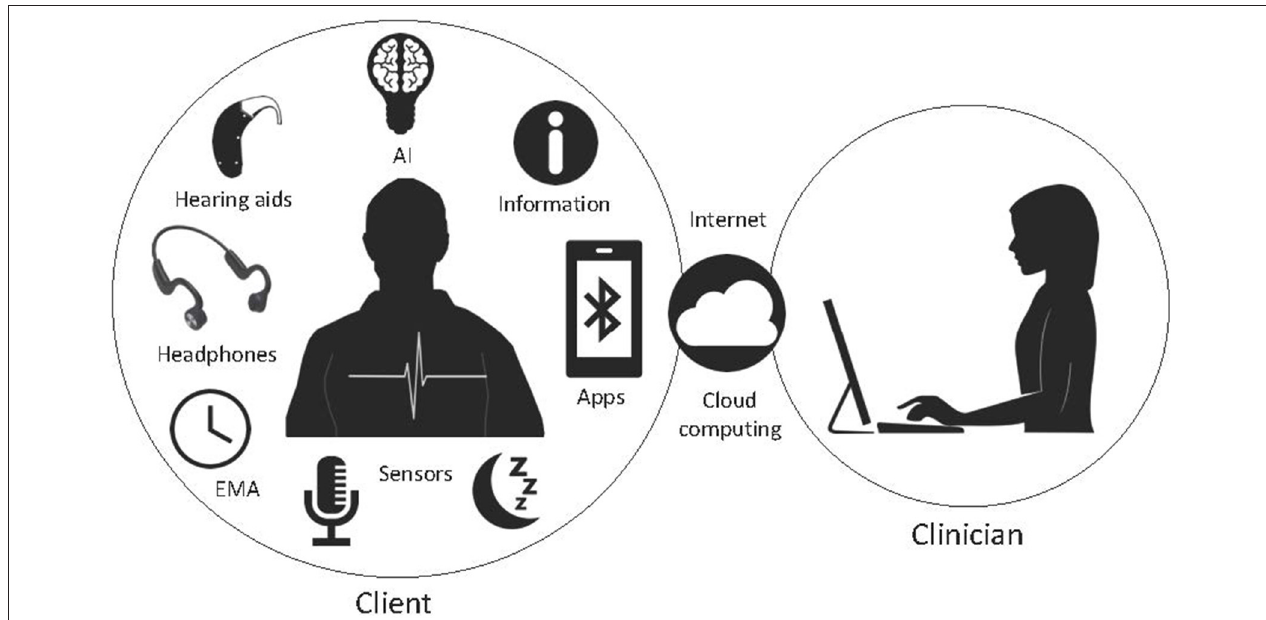
FIGURE 6 | A potential future digital therapeutic system consisting of an app-based therapy that uses AI to configure transducers, counseling, EMA, biosensors and connect to clinicians via cloud